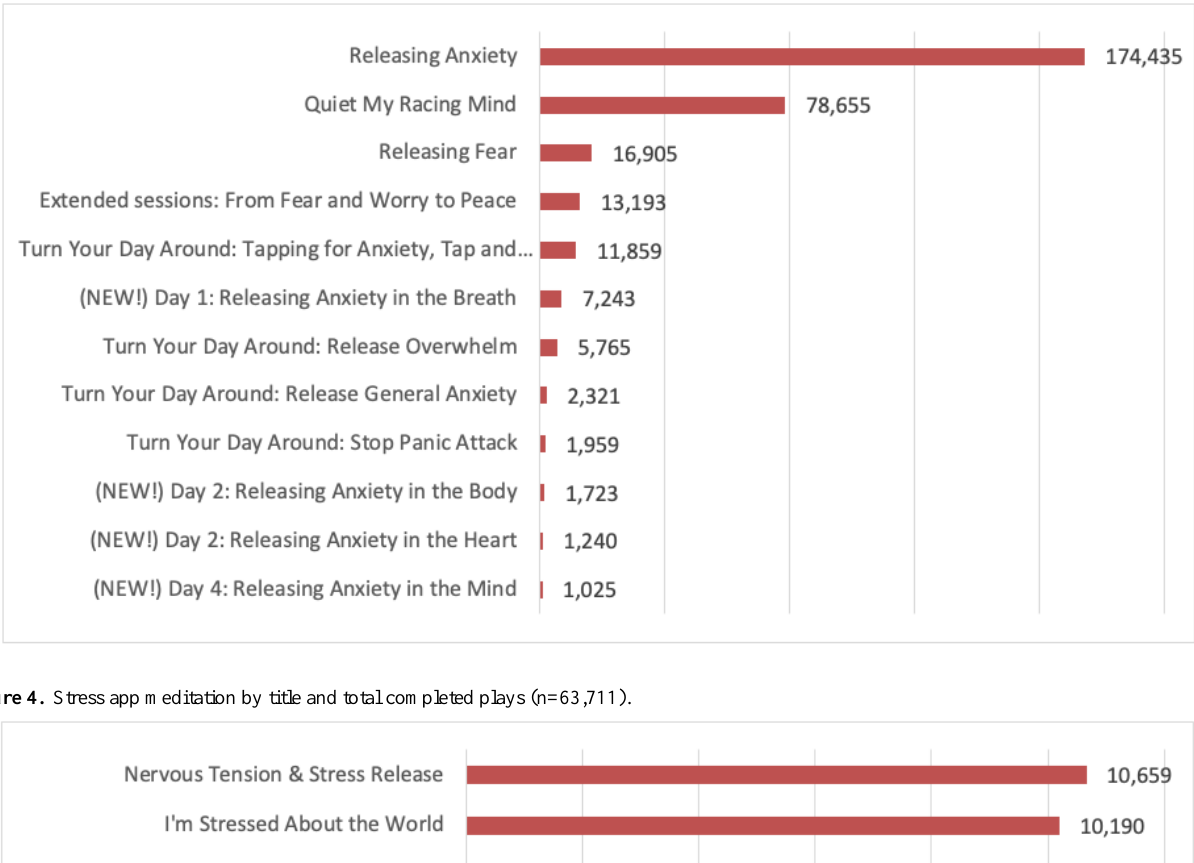
Figure 3. Anxiety app meditation by title and total completed plays (n=316,323).